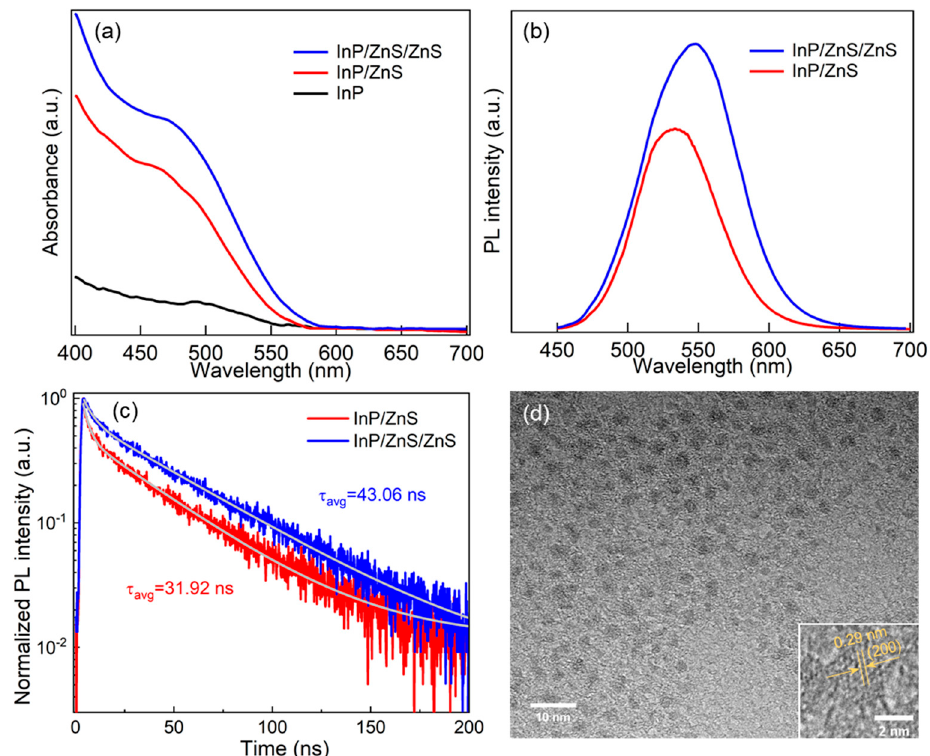
Figure 1. Absorption ( a ) and PL ( b ) spectra of InP and their core/shell QDs, ( c ) PL decay of InP/ZnS and InP/ZnS/ZnS QDs, ( d ) a typical TEM image of InP/ZnS/ZnS QDs, and the inset is a high resolution TEM image.